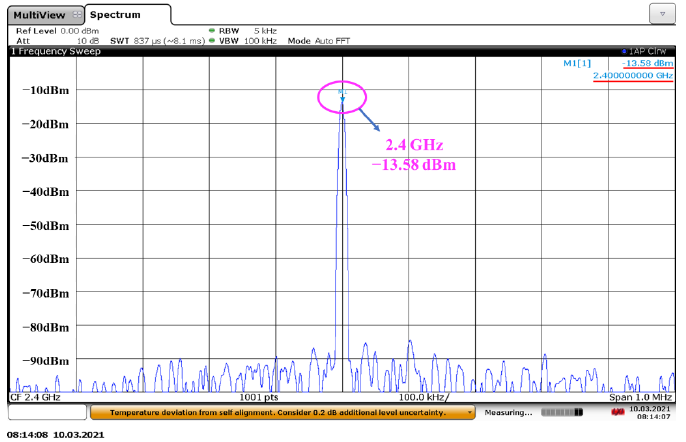
Figure 9. The test results of the FD: the frequency spectrum at input of 4.8 GHz.